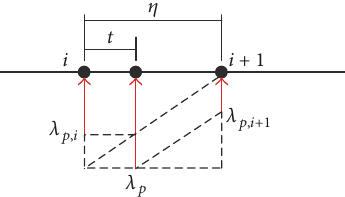
Figure 6: The equivalent load of a moving